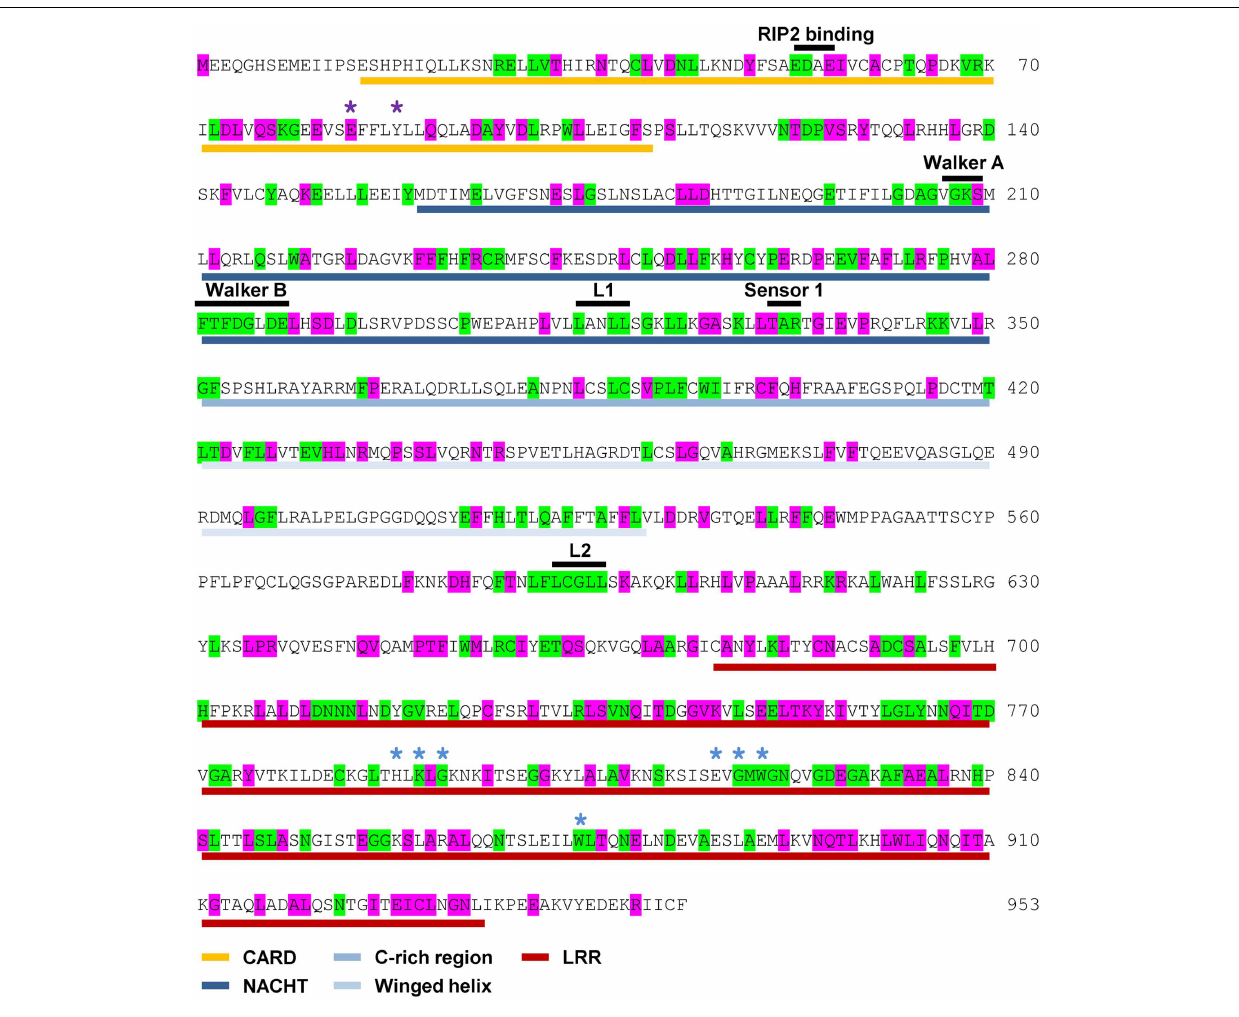
FIGURE 2 | Pattern of cross-species residue conservation in NOD1 . Residues conserved across all NOD1 species checked, or just across mammals, are highlighted green and purple respectively. Residues are mapped onto the amino acid sequence for human NOD1.The domain architecture is highlighted underneath the relevant stretch of sequence as follows: CARDs – gold; NACHT – dark blue; C-rich region – blue;